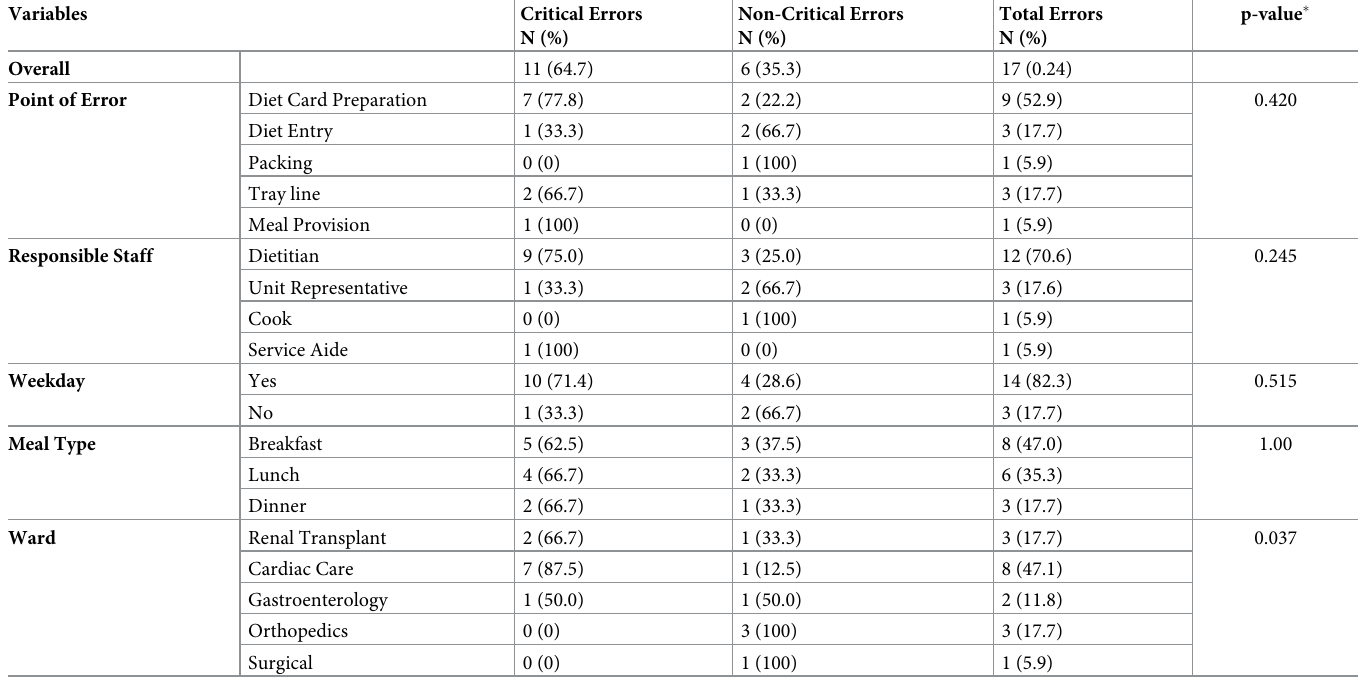
Table 3. The percentage wise distribution of dietary errors (N =